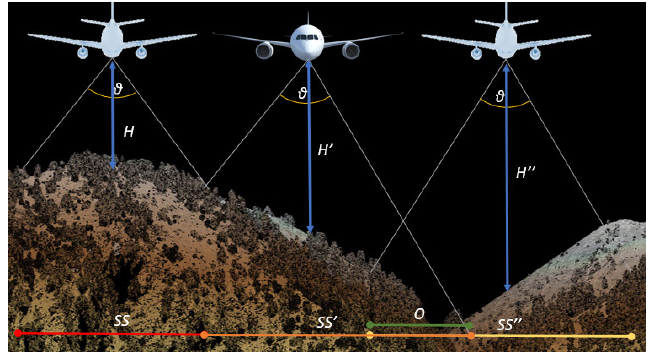
Figure 13. Example of variations in aboveground flying height ( H , H (cid:48) , H ”) and scanning swath ( SS , SS (cid:48) , SS ”) over mountainous terrain ( θ = scan angle and O = overlapping